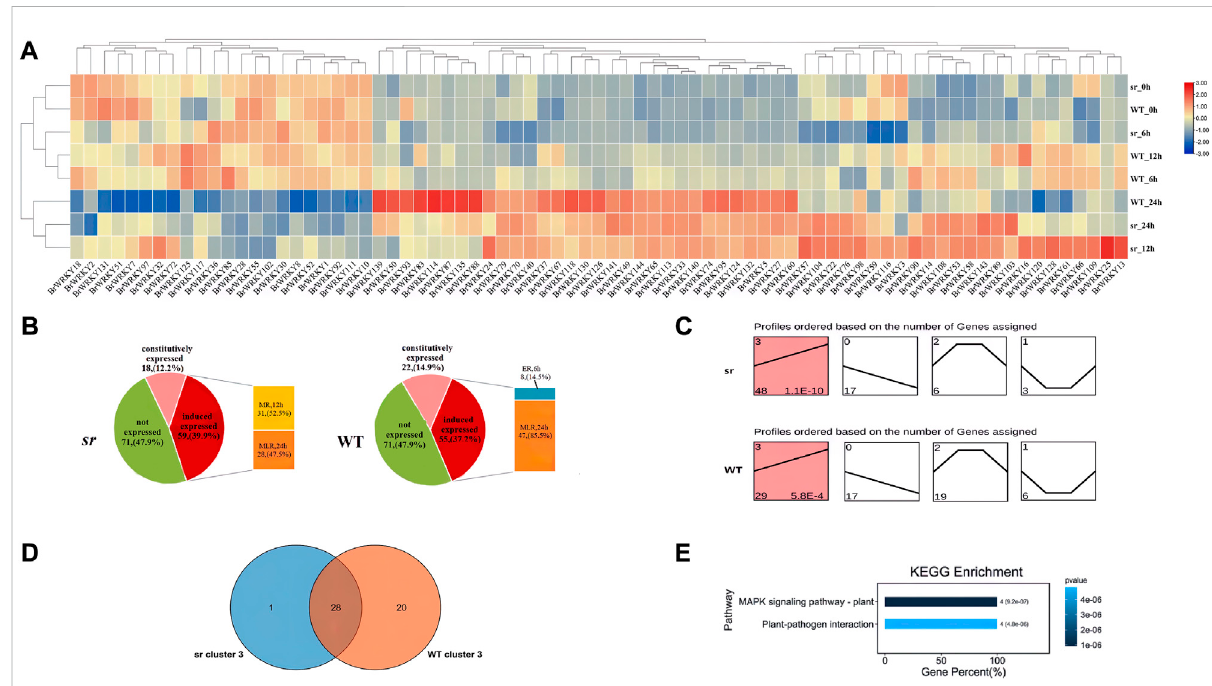
FIGURE 4 Expression response of BrWRKYs to Pc inoculation. (A) Heatmap of WRKY family members in Chinese cabbage response to Pc infection. (B) Analysis of the expression trend of BrWRKYs under soft rot stress. These BrWRKYs can be divided into early response (6 hpi, ER), middle response (12hpi,MR),andmiddleandlateresponse(24hpi,MLR)genes. (C) Transcriptionalpatternsoftheexpressionof77BrWRKYmembersinWTandsrare shownin (C) . (D) Relativetoclusters0 – 2,cluster3isthedominanttype,withthelargestnumber,andthe p -valueismoresigni fi cant,includingsr 48 and WT 29 BrWRKYs, and 28 were identi fi ed in both lines and are shown in the Venn diagram. (E) KEGG functional enrichment analysis for cluster 3. Cluster 3 expression was upregulated at 0 – 24 hpi of soft rot